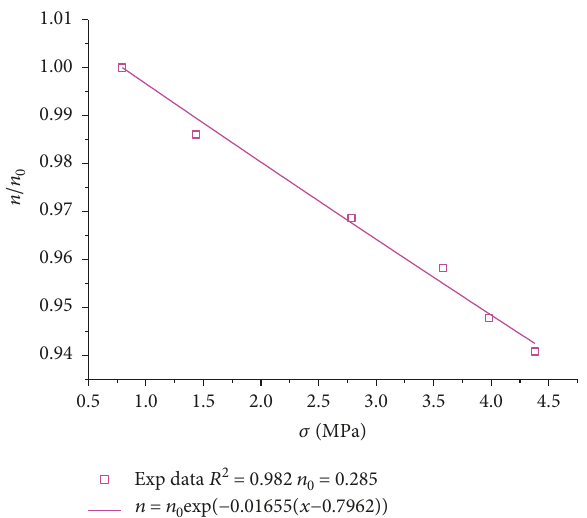
Figure 4: Power function relationship between porosity and